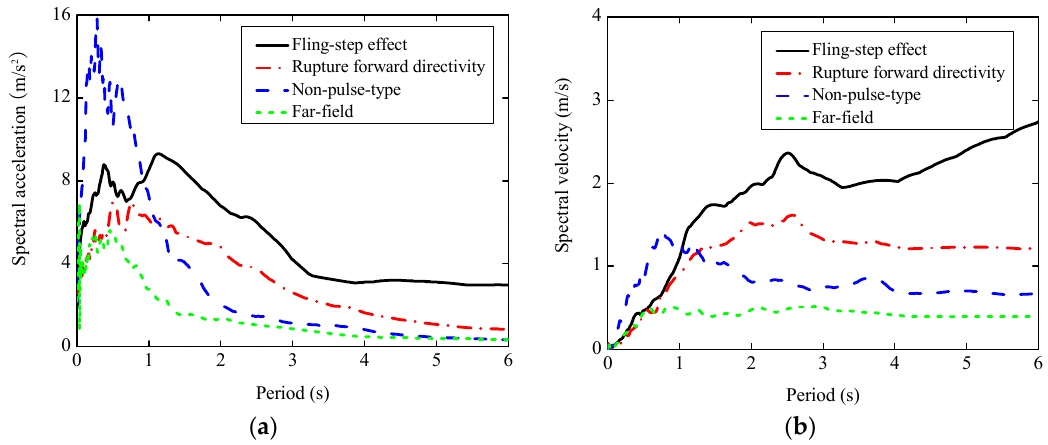
Figure 2. Average acceleration and velocity response spectra for different types of earthquakes: ( a ) spectra acceleration; and ( b ) spectra velocity.